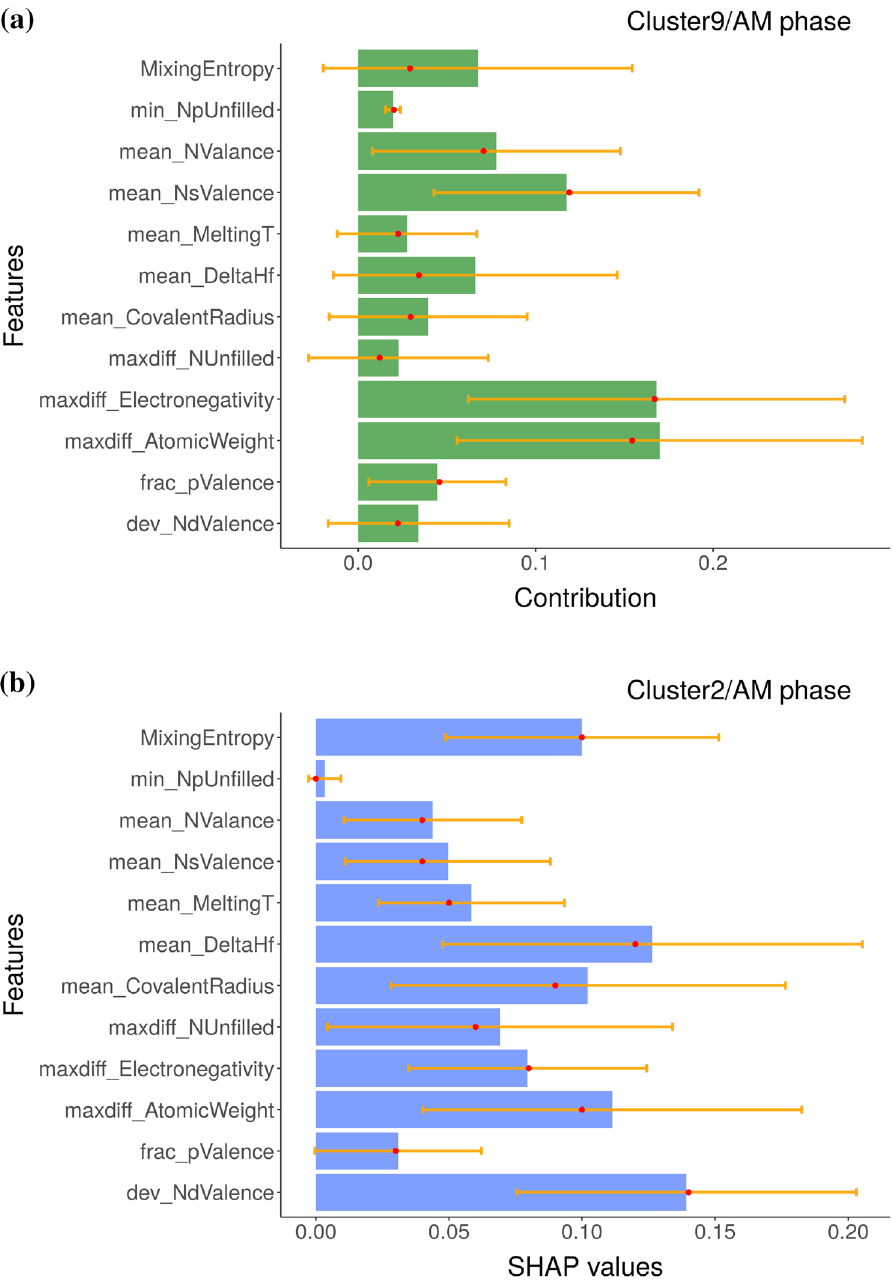
Figure 5. The ( a ) BD and ( b ) SHAP decomposition are plotted for the representative clusters (clusters 9 and 2, respectively), which are predicted to have AM phase by the eSVM model. The size of each bar indicate the averaged contribution of the respective variables towards the overall prediction for a given instance. Red dots and yellow lines denote median values and error bars, respectively. The y-axis of SHAP plot are sorted in the same way as those of BD plot to facilitate the comparison of two